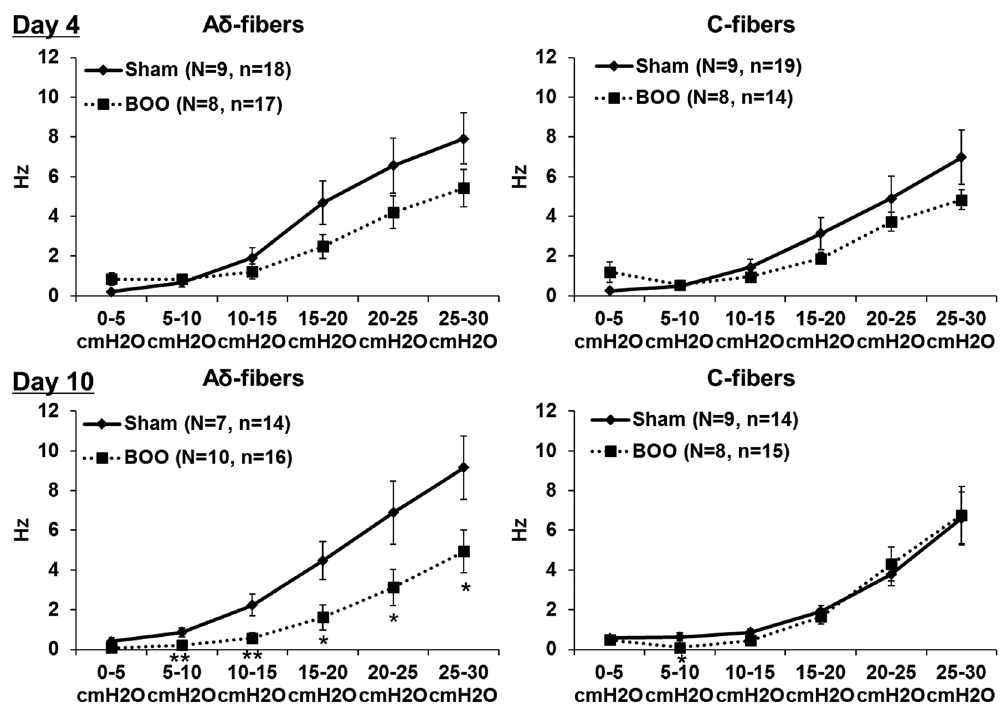
Figure 2. Influence of BOO-induction on mechanosensitive SAAs of the A δ - and C-fibers. The horizontal and vertical axes indicate the intravesical pressure and firing rate of SAAs, respectively. Values are expressed as mean ± SEM. * P < 0.05, ** P < 0.01: significant differences from the Sham rats (unpaired Student’s t -test). On both study time-points (day 4 and 10), the BOO rats showed lower SAAs of A δ -fibers than the Sham rats.